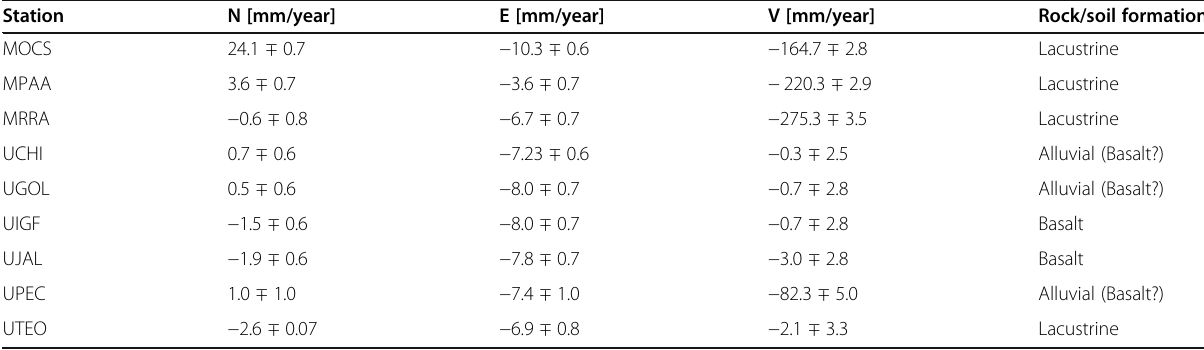
Table 1 Deformation rates of CGPS stations in the Mexico City area (point positioning solution, ITRF-2000 networks). For the location of CGPS stations, see Fig. 2. For geology, see Fig. 3 Station N